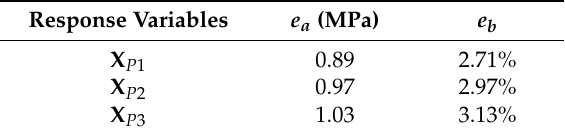
Table 2. The summarized errors using different response variables.